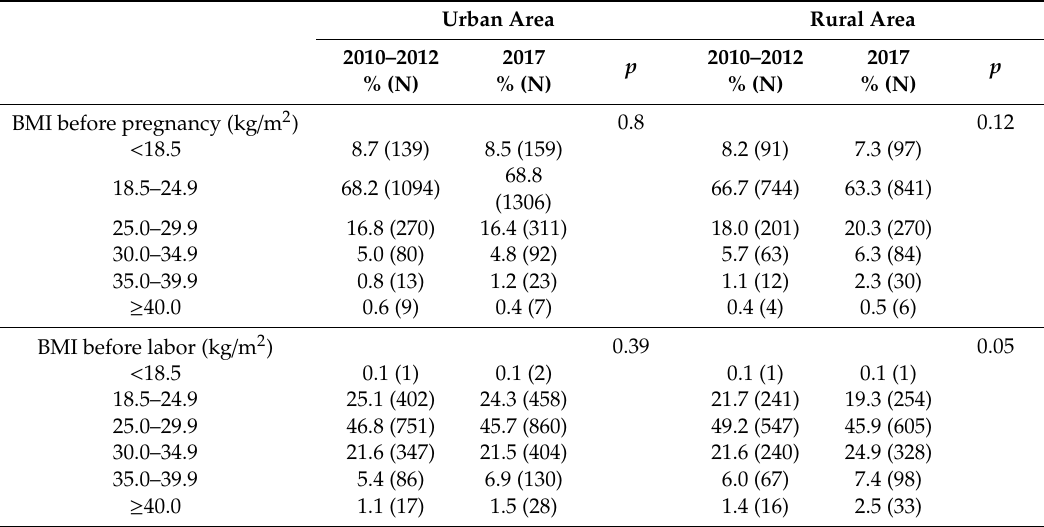
Table 4. Body Mass Index (BMI) of women living in rural and urban areas in Poland, before pregnancy and before labor, in the years 2010–2012 and